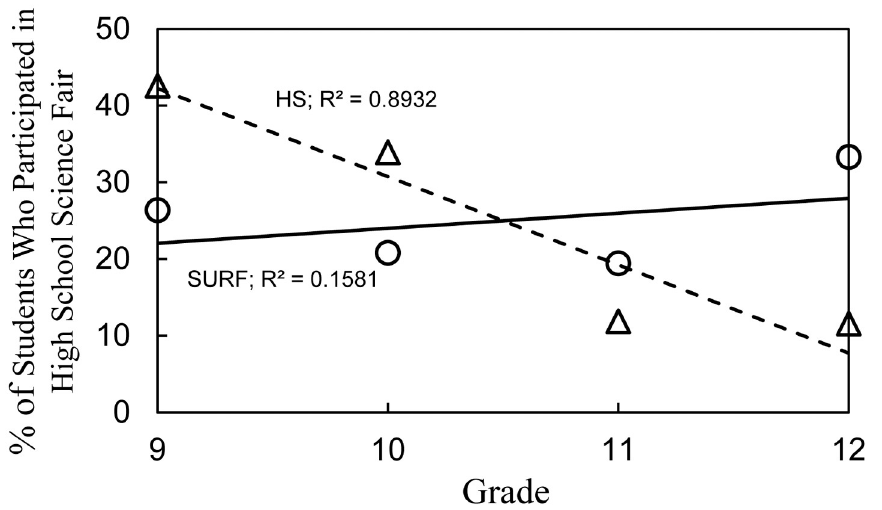
Fig 1. SURF vs. high school students—Grade in which students participated in science